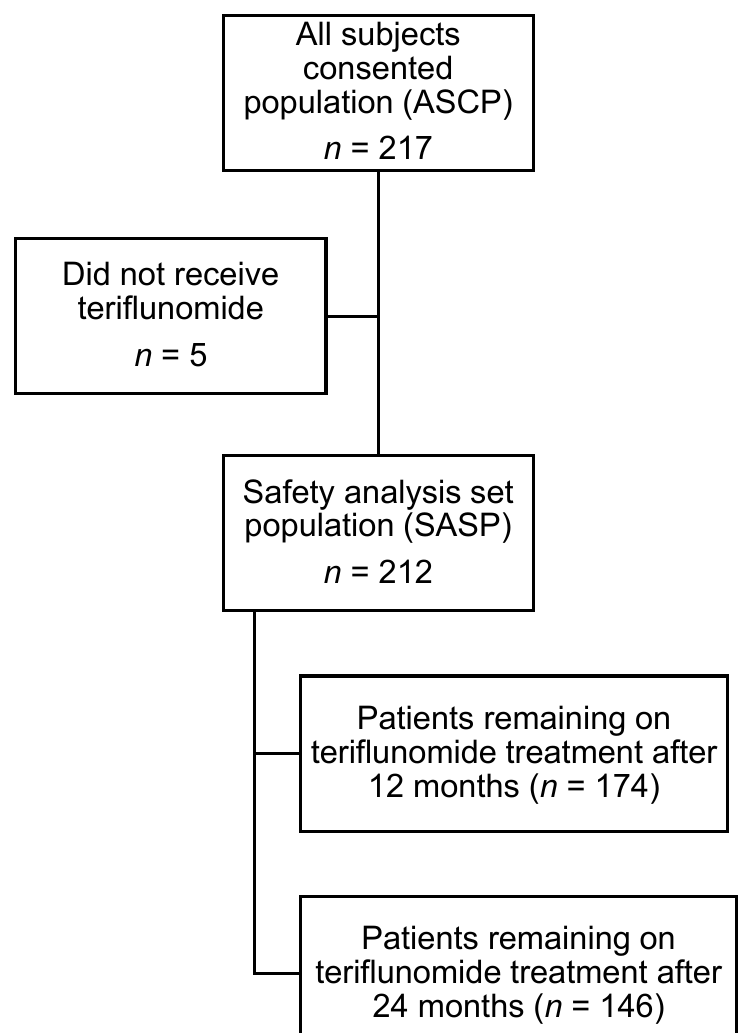
Figure 1. Patient enrolment and outcomes in Teri-REAL. Baseline patient characteristics (All Subjects Consented Population; ASCP) are pre- sented in Table 1. The mean age ( ± SD) of patients was 41.8 ± 9.6 years, and 150 of the 217 patients (69.1%) were female. Here, 109 patients (50.2%) were treatment-naïve. Of those who had received treatment with a DMT prior to participating in the study ( n = 107), more than 80% had been prescribed first-line injectable drugs. One patient had previously been treated with two different